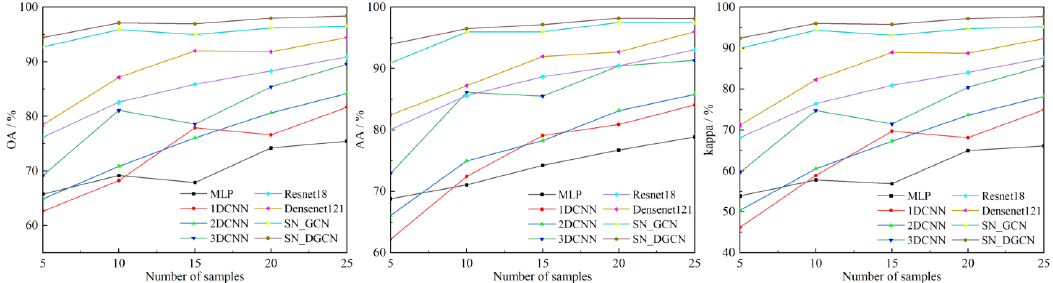
Figure 8. Classification accuracy of different training samples.